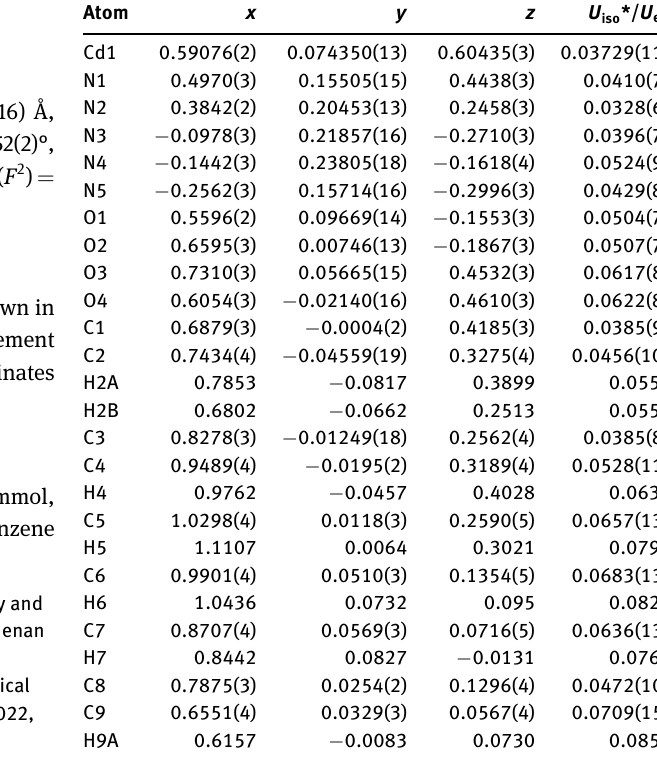
Table 2: Fractional atomic coordinates and isotropic or equivalent isotropic displacement parameters (Å 2